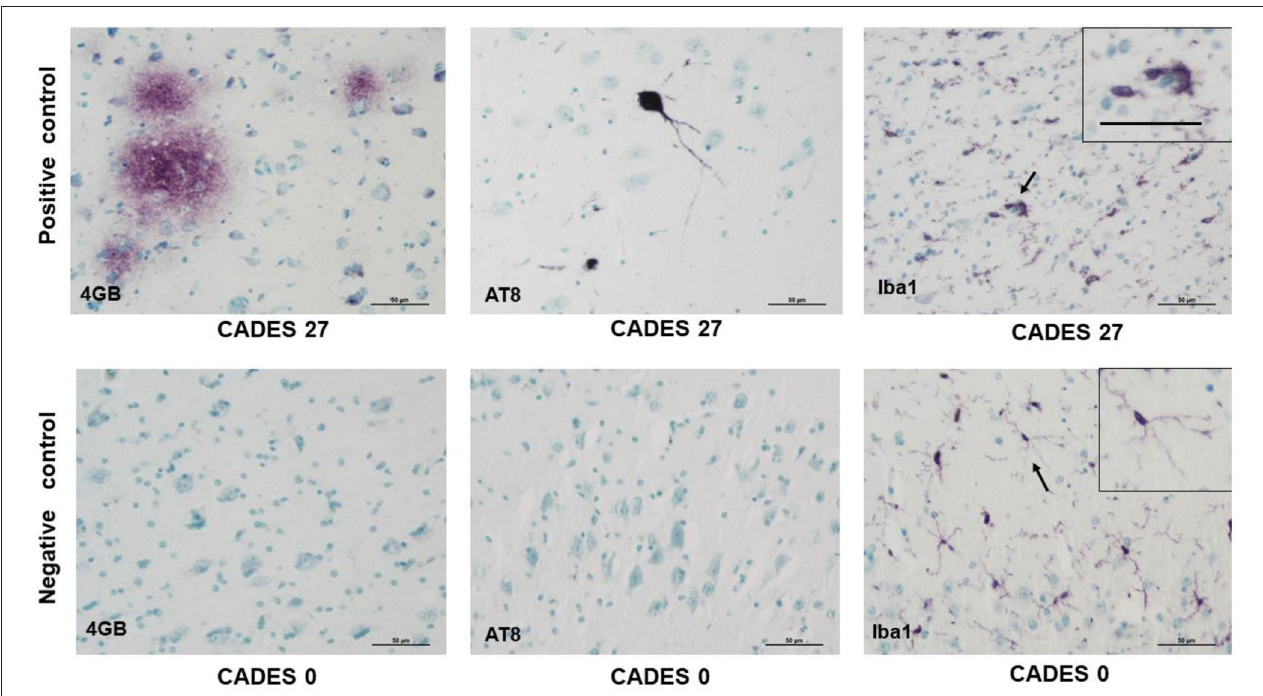
FIGURE 6 | Immunohistochemistry of cortex in positive control/dog with cognitive declaim (CADES 27) and negative control/dog with normal cognition (CADES 0) showed differences in all three antibodies. While in positive control, we could identify amyloid deposits (4GB), occasional TAU (AT8) pathology, and activated microglia (Iba1), with amoeboid morphology (indicated by arrow), cortex of negative control was free of amyloid and TAU. Resting microglia with fine, ramified processes was detected (indicated by arrow). Note, inserts in positive/negative control with higher magnification of microglia morphology. Scale bars: 50 µ